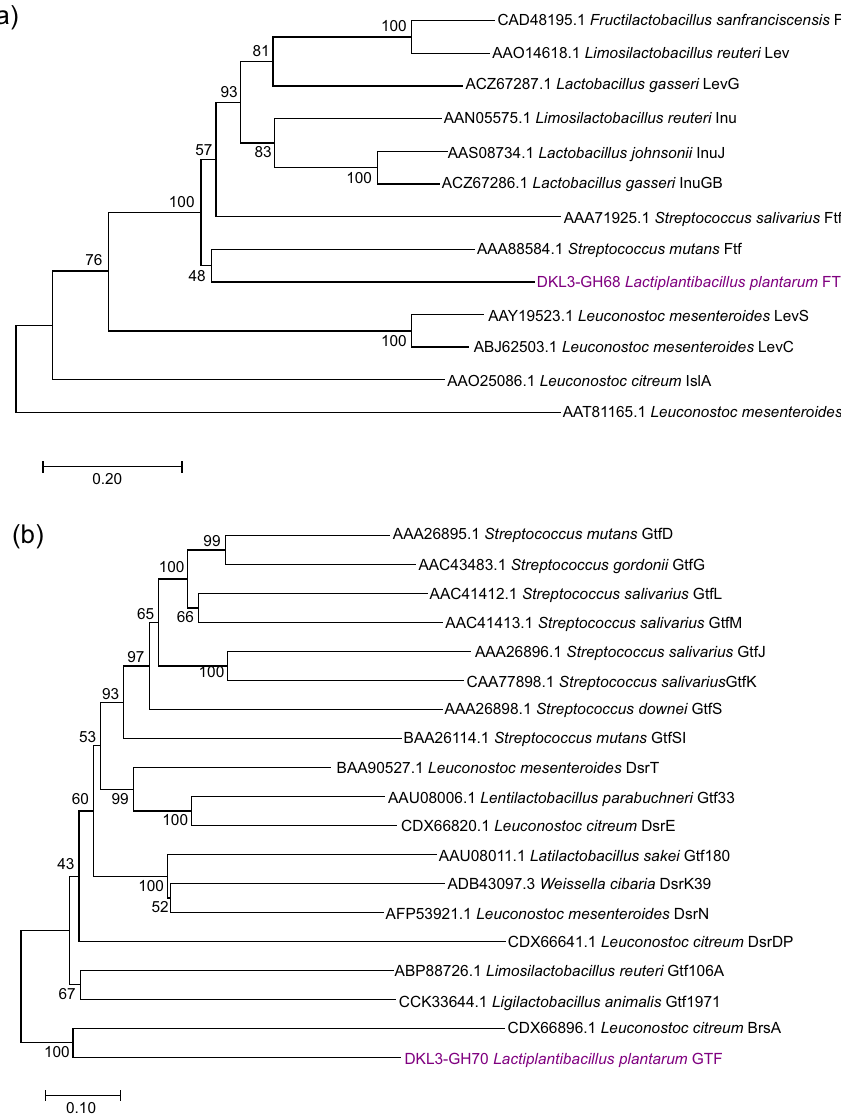
Figure 5. Phylogenetic analysis of fructansucrases ( a ) and glucansucrases ( b ) from L. plantarum DKL3 with the respective characterized enzymes from other LAB. The analysis was carried out by neighbour-joining method using MEGA X (https:// www. megas oftwa re. net/) 96